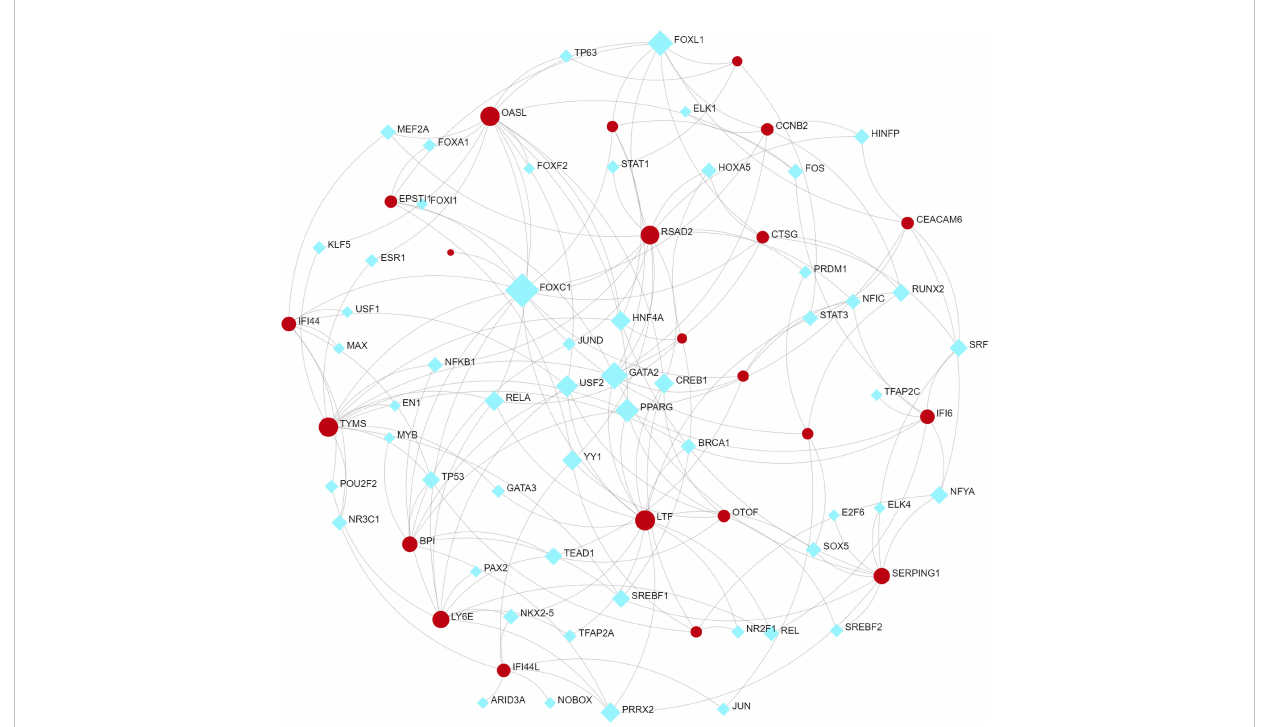
FIGURE 5 The cohesive regulatory interaction network of DEG – TFs obtained from the Network Analyst.